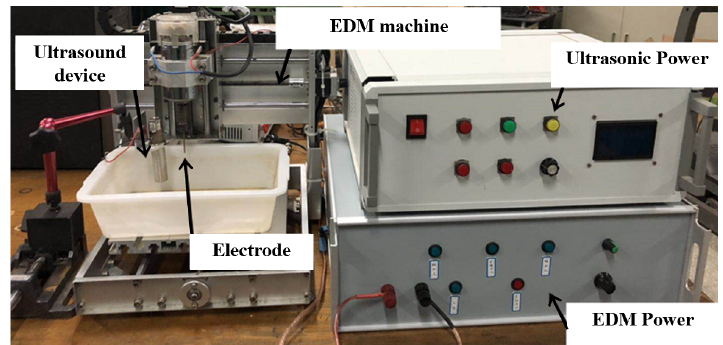
Figure 3. Ultrasonic-assisted EDM grinding machine. Table 1. Experimental parameters of EDM grinding.